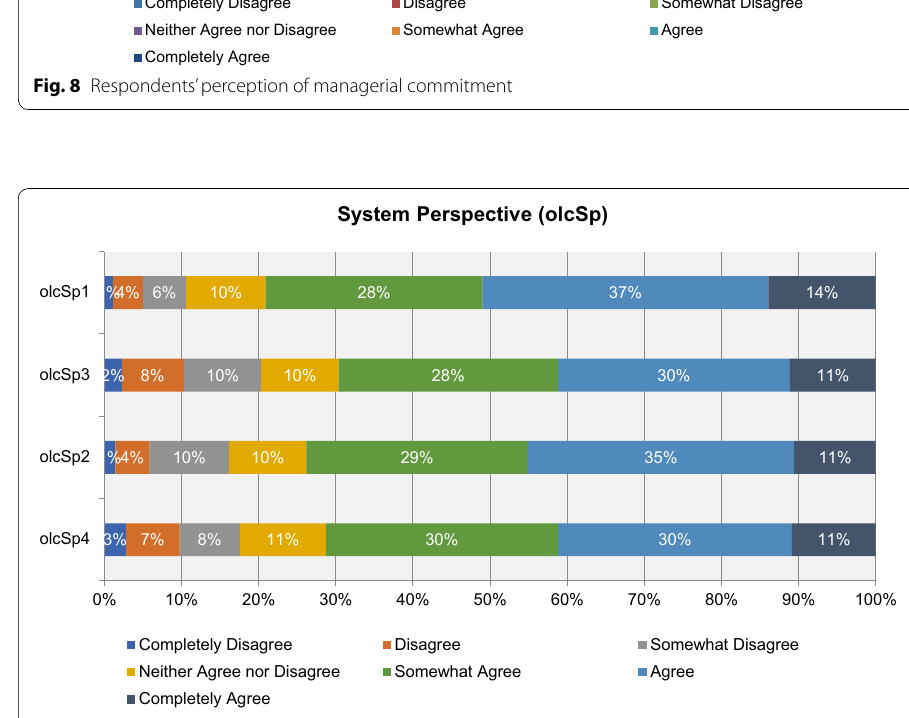
Fig. 9 Respondents’ perception of system